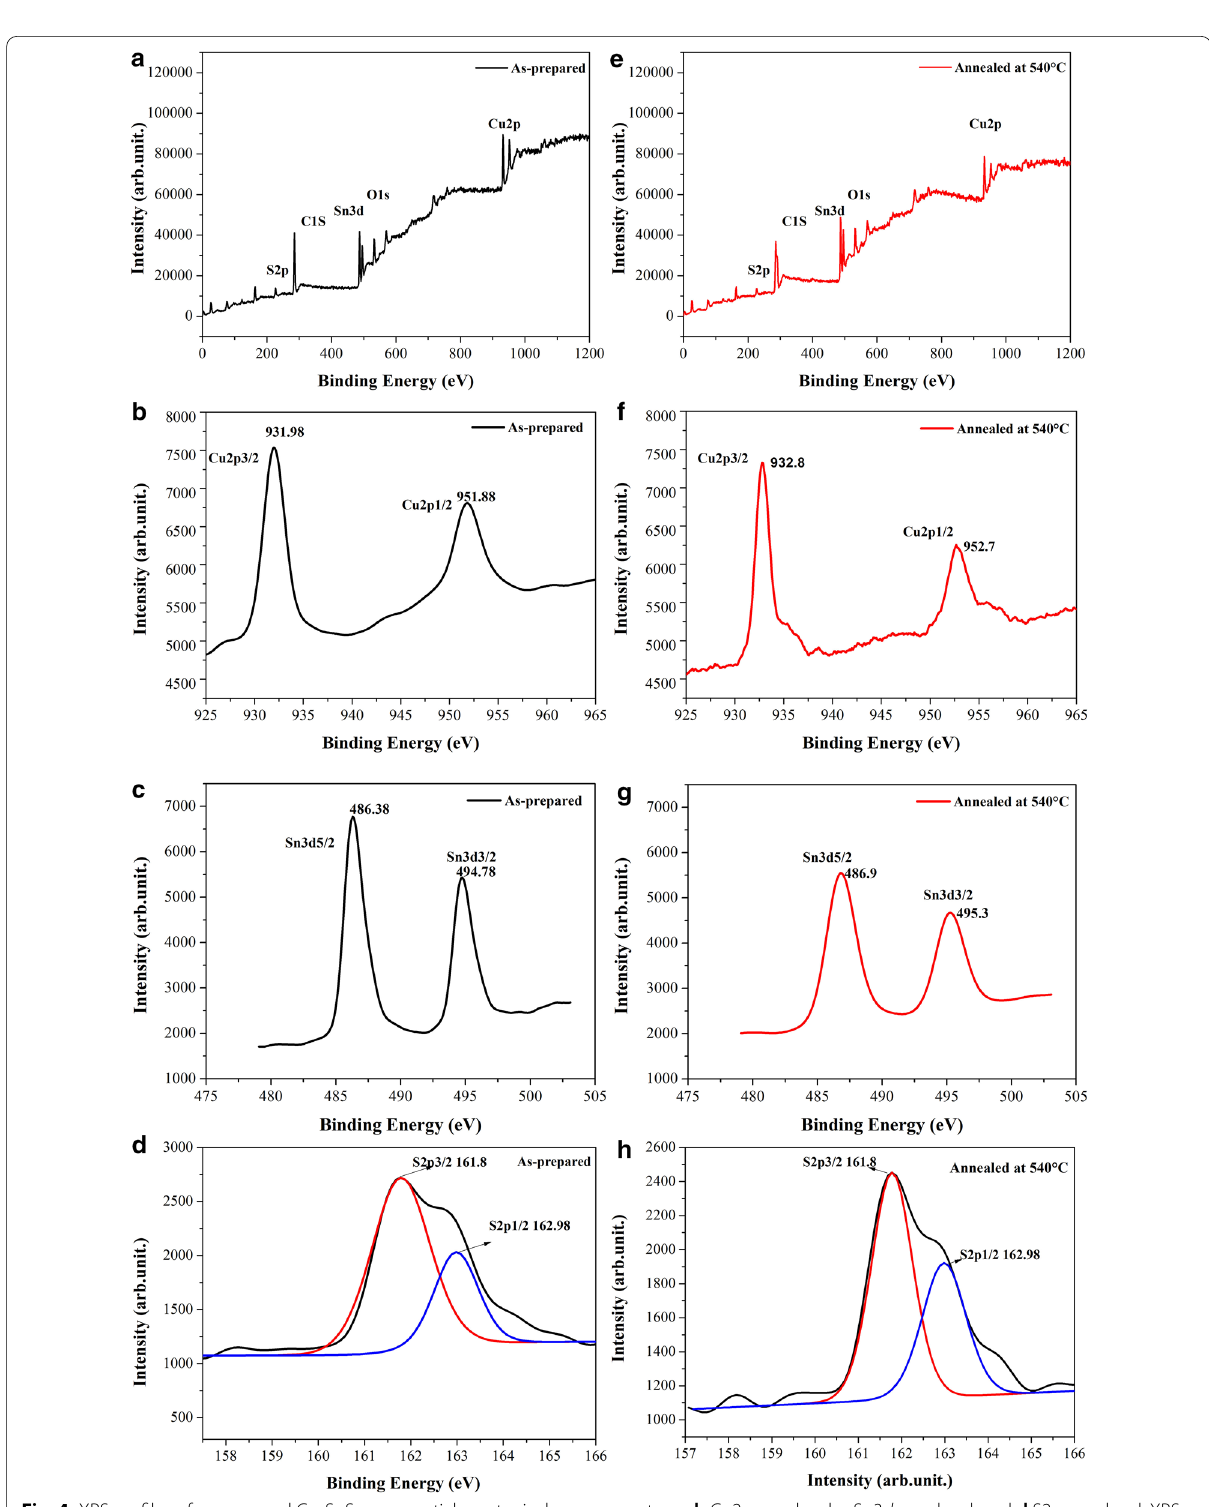
Fig. 4 XPS profiles of as-prepared Cu 2 SnS 3 nanoparticles: a typical survey spectrum, b Cu2 p core level, c Sn3 d core level, and d S2 p core level. XPS spectra of annealed